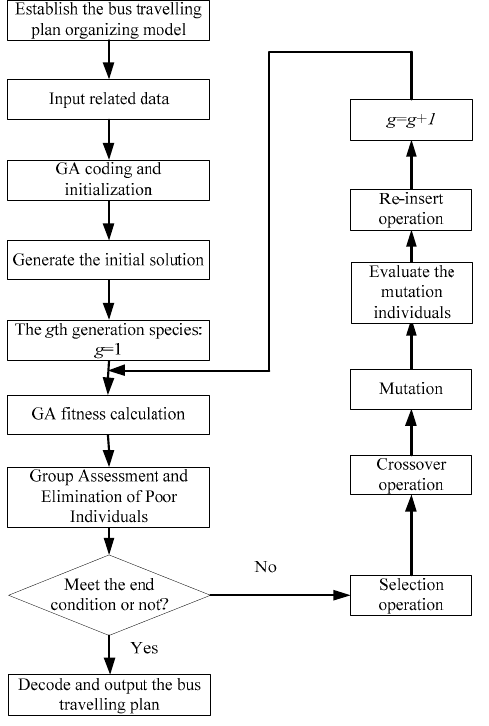
Figure 3. Flow diagram of the algorithm.